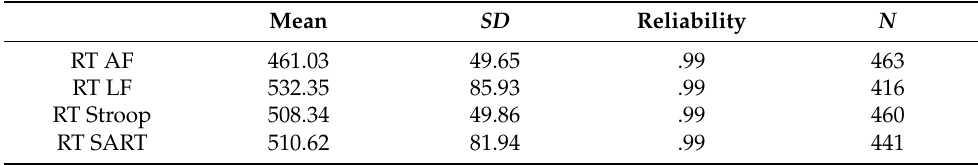
Table 5. Descriptive statistics of all RT variables in Study